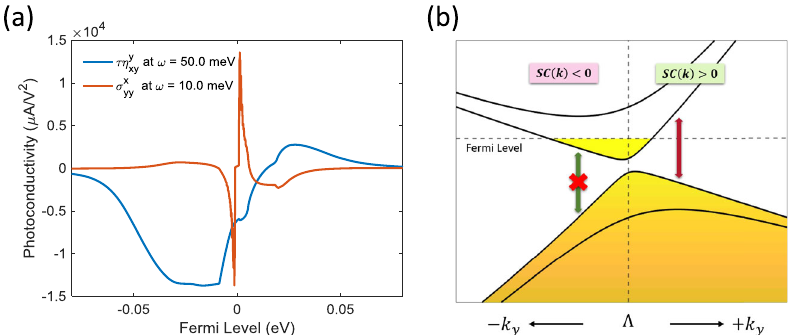
Fig. 6 Nonlinear photoconductivities under Fermi level tuning. a The CC and SC conductivities of MoSTe as a function of the Fermi level E F . = 0 denotes that the Fermi level is at the valence band maximum. b An illustration that explains the sharp jump in the photoconductivity E F when E F is slightly inside the valence band or the conduction band.